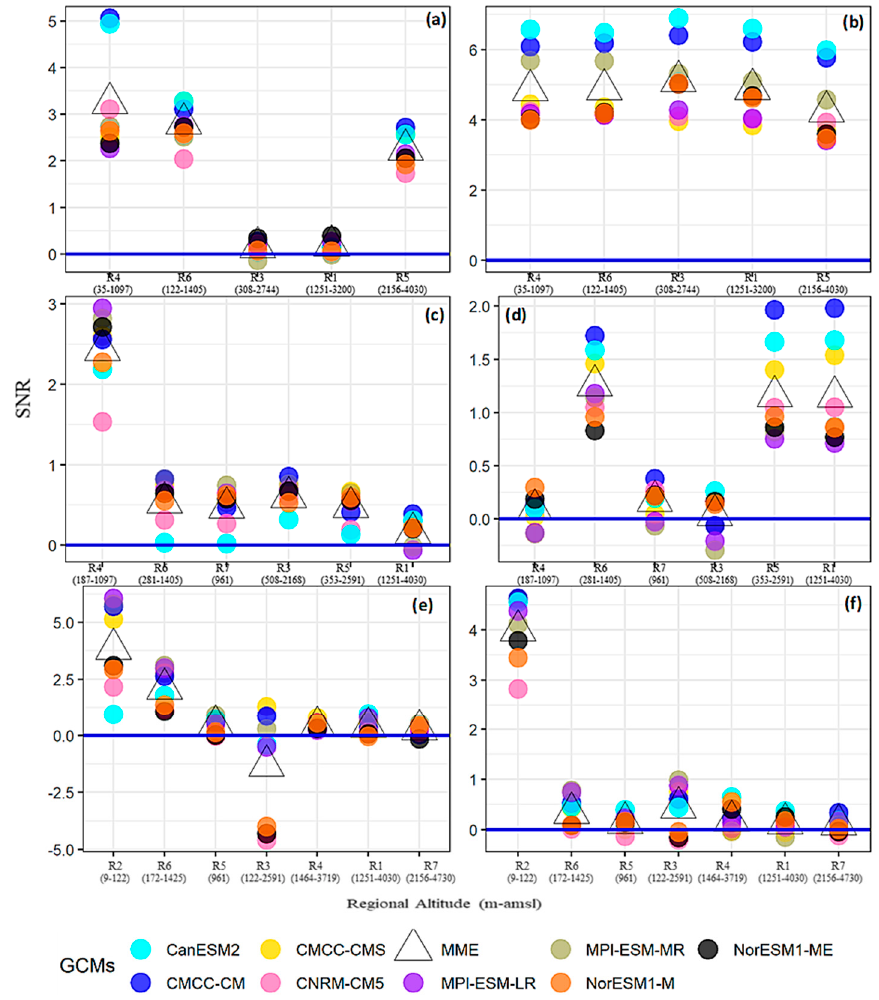
Figure 8. Same as Figure 5, showing the basin-wide distribution of the signal to noise ratios (SNRs) for both temperatures during 2071–2100 under RCP8.5. The blue horizontal solid line here depicts no strength of the change signal (i.e., median) compared to the historical standard deviation (i.e., noise). Sub-regions with their altitudinal bands are shown along the x-axis, where the elevation increases from left to right. Note that WS T max and T min changes are shown as ( a , b ). Corresponding PMS and MS temperature changes are shown by ( c , d ) and ( e , f ), respectively.